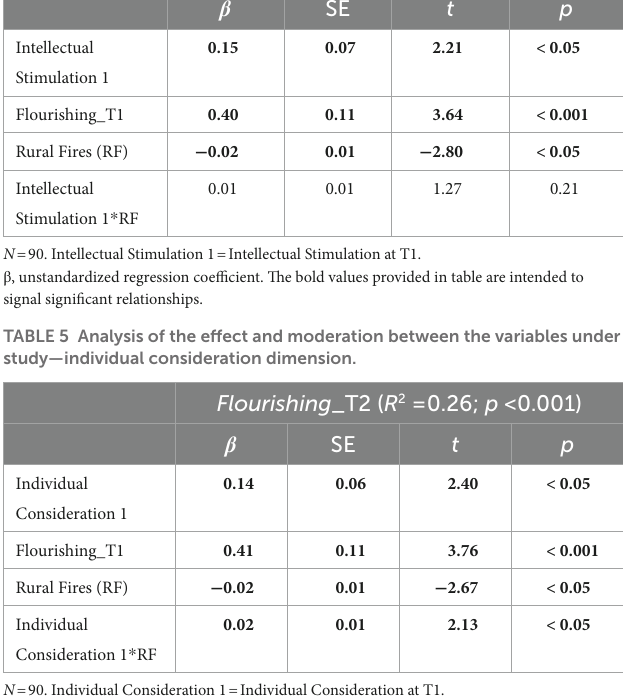
signal significant relationships.